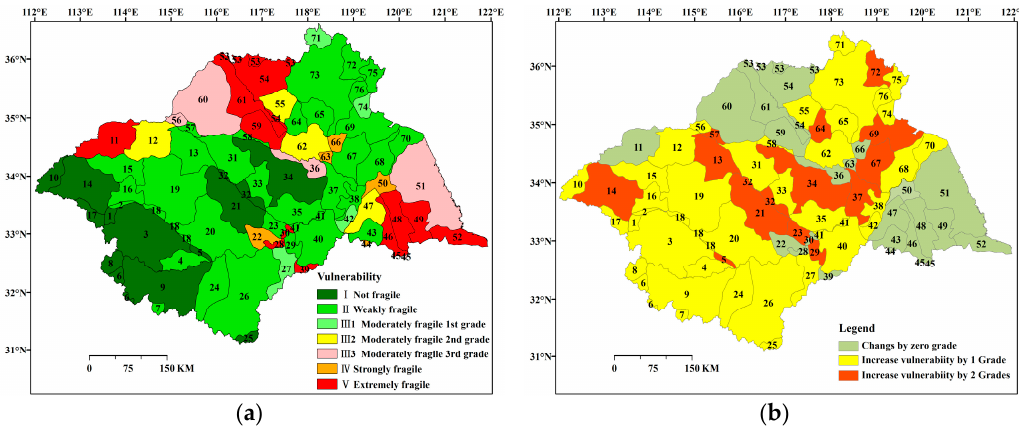
Figure 8. ( a ) Water resource vulnerability at the Municipality ‐ Class III WRR scale with the method of Xia and Chen; and ( b ) the grade of vulnerability change compared with the vulnerability results with the method in this manuscript. The names of Municipality ‐ Class III WRRs are the same as given in Figure 7.